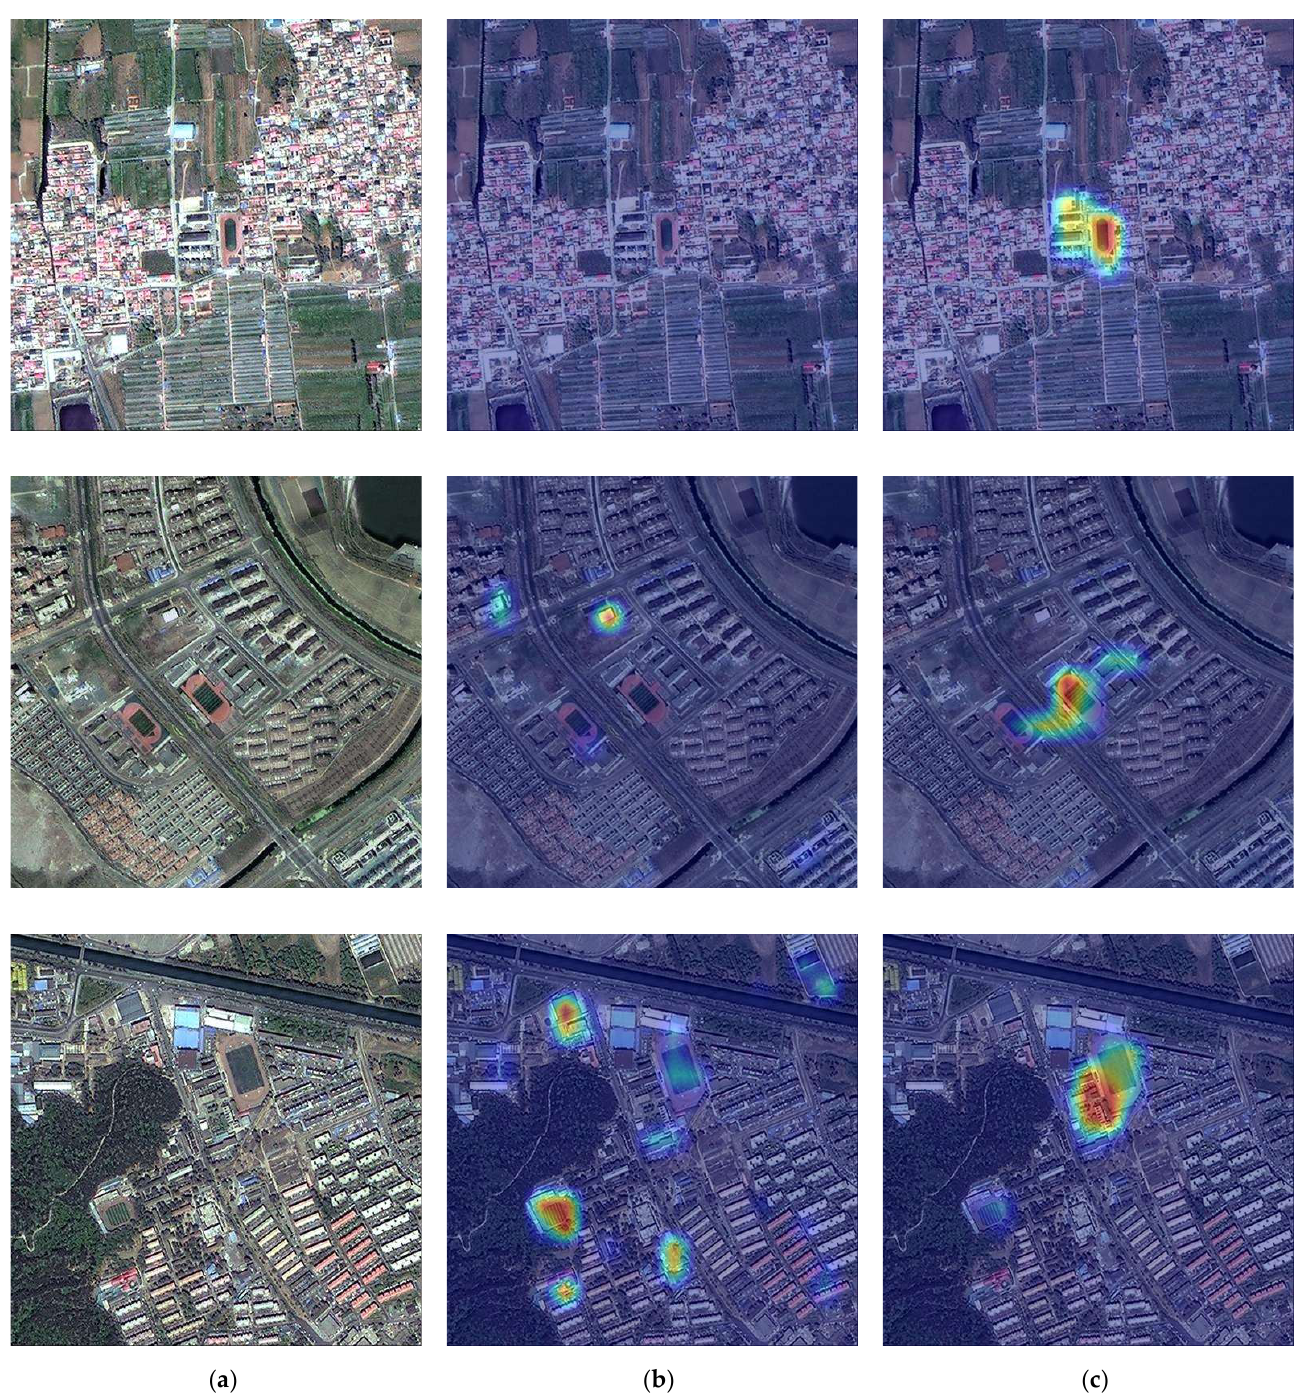
Figure 12. Verify the effects of DAM via visualizing attention map: ( a ) examples of the input image; ( b ) heatmap visualization results of input of DAM corresponding images; ( c ) heatmap visualization results of the output of DAM corresponding images.